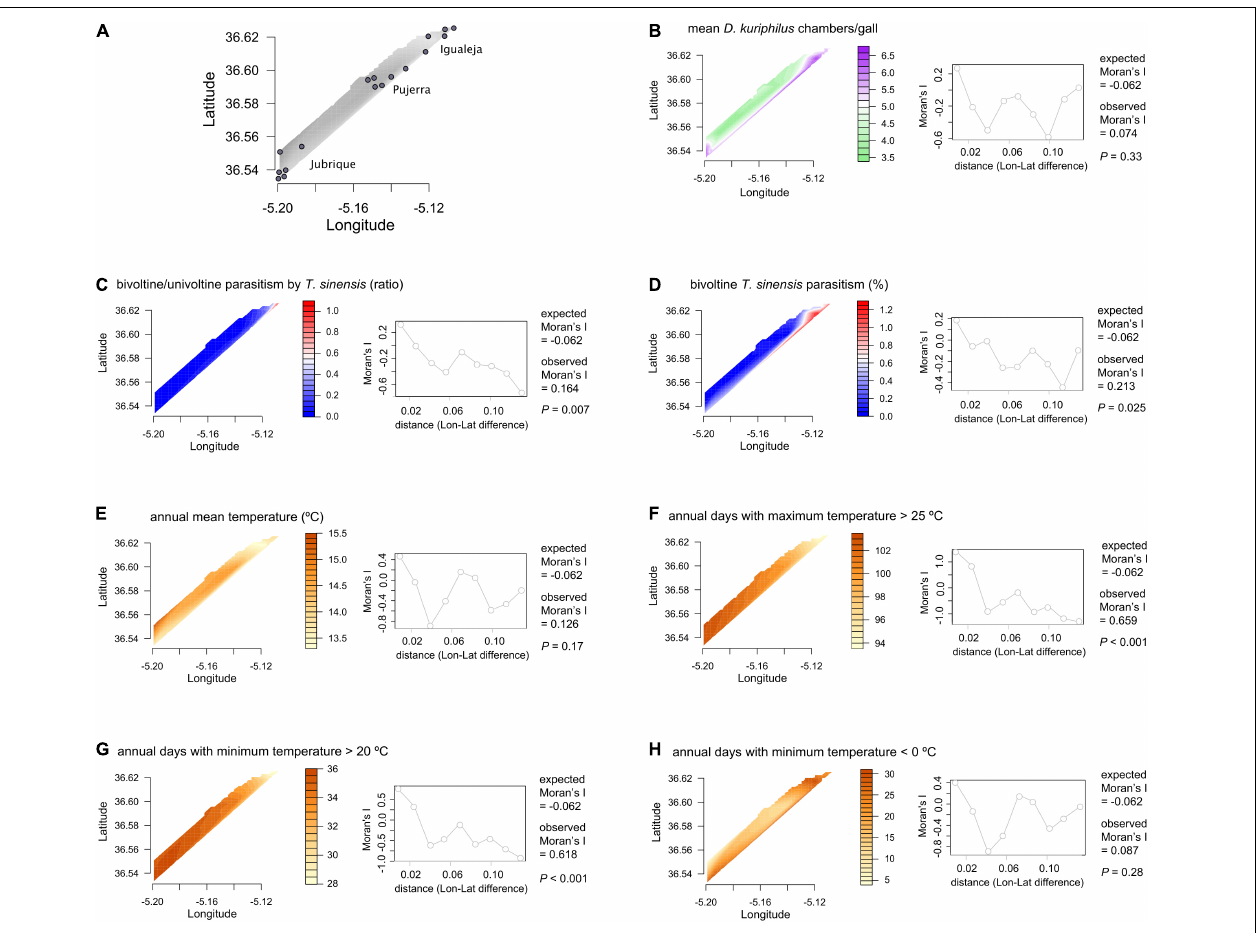
FIGURE 1 | (A) Spatial distribution of the 17 sampling locations in Málaga province, Spain. (B–H) Spatial contour plots, Moran’s I statistics and correlograms for all dependent and explanatory